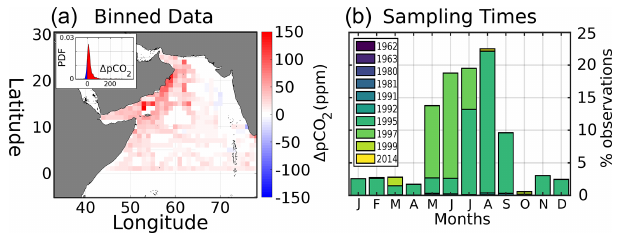
Figure 2. (a) Average surface in situ (cid:49) p CO 2 (ppm), with proba- bility density function of all (cid:49) p CO 2 values inset. (cid:49) p CO 2 data are calculated in comparison to Keeling atmospheric p CO 2 and then binned into a 1 ◦ × 1 ◦ grid. (b) Monthly distribution of in situ data sampling times, color-coded by sampling year.